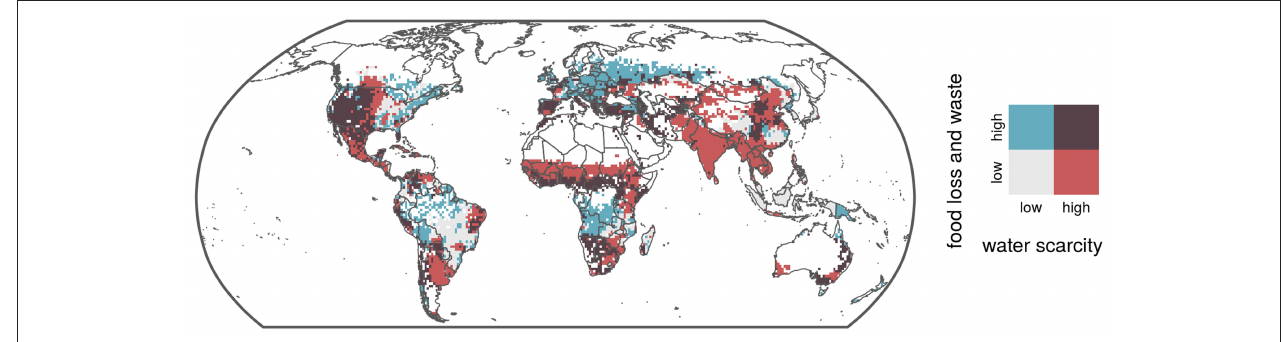
FIGURE 1 | Map overlapping local water scarcity and crop-specific rates of food loss and waste within the region. Dark grid cells represent areas with high levels of water scarcity and high regional rates of loss and waste of the predominant crops grown within the grid cell. Water scarcity data are from Mekonnen and Hoekstra (2016), crop area data are from Monfreda et al. (2008), and food loss and waste rates are from Gustavsson et al.